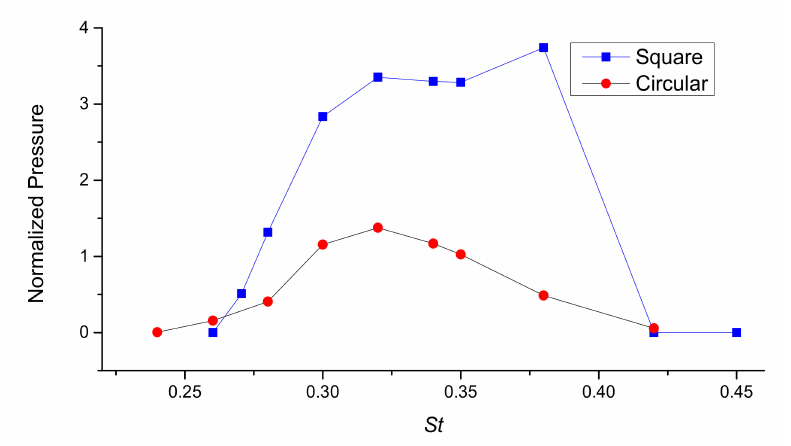
Figure 9. Variation of pressure fluctuation with